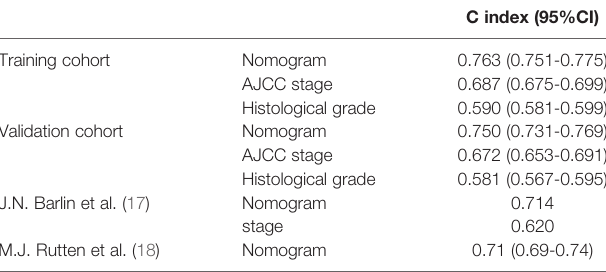
TABLE 3 | Comparison of C-indexes in EOC